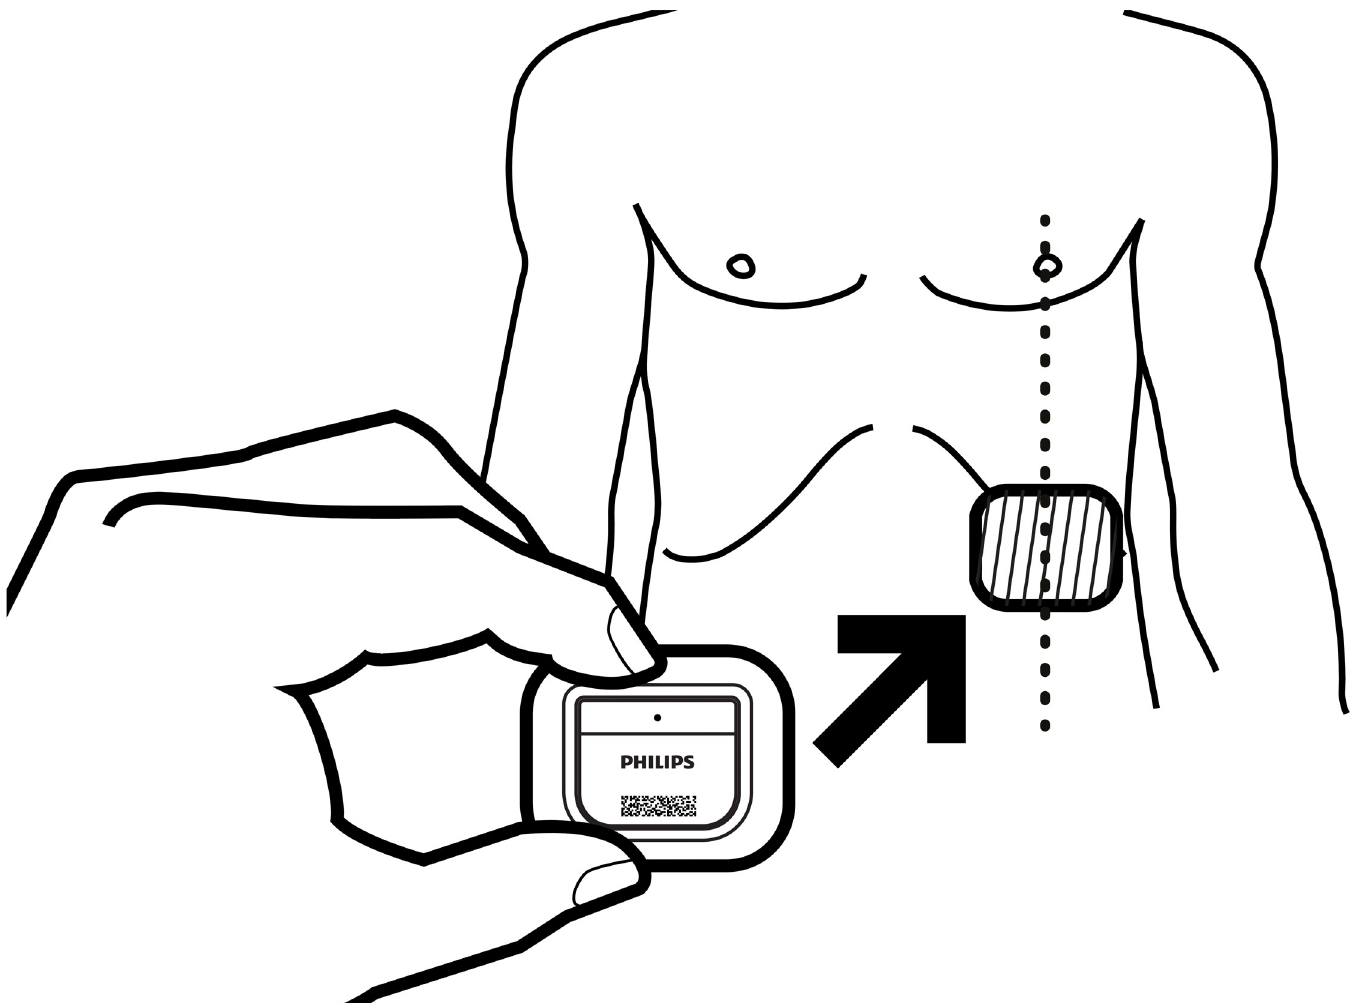
Fig 1. Schematic view of the Healthdot. Reprinted from Philips Electronic Nederland BV under a CC BY license, with permission from Philips Electronic Nederland BV, original copyright 2020.